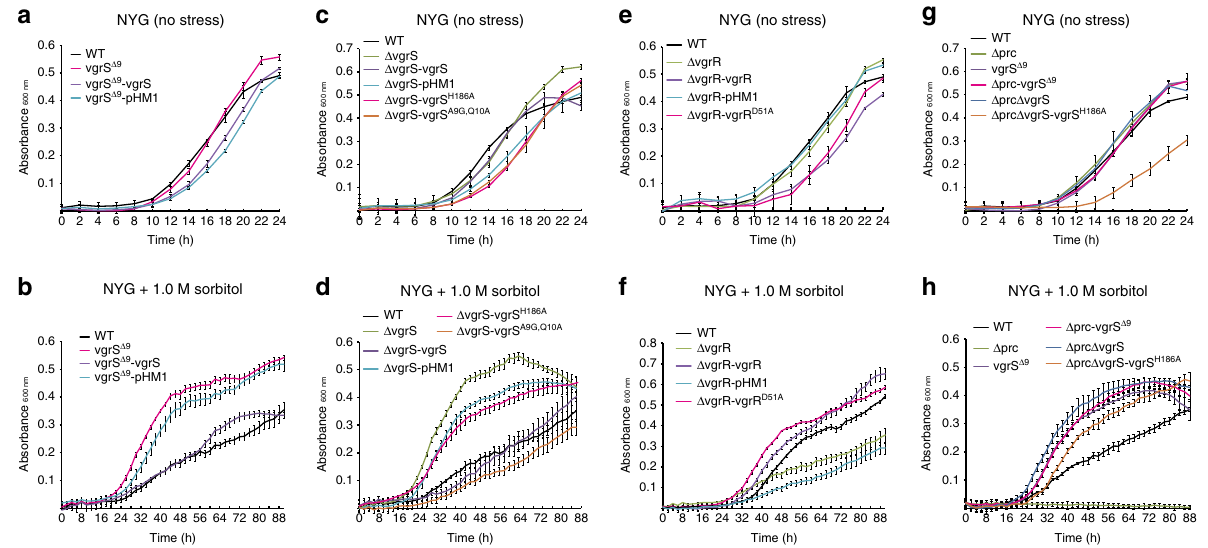
Fig. 6 Deletion of the N-terminus of vgrS suppresses the growth de fi ciency of the prc mutant under osmostress. a , c , e , and g Bacterial growth in NYG medium. b , d , f , and h Bacterial growth in NYG medium plus 1.0 M sorbitol. The growth curves were measured by an automatic Bioscreen C instrument. Each data point is the average of six samples, and error bars indicate standard